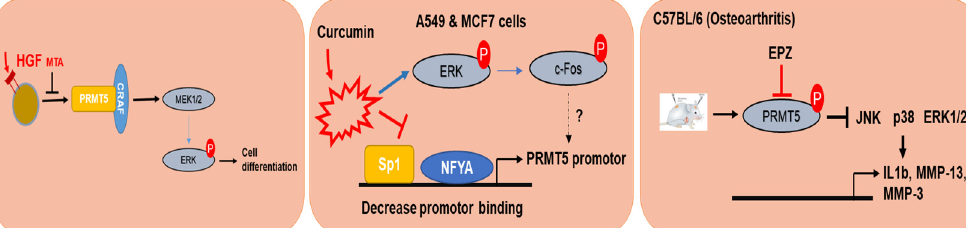
Figure 4. Mechanism and action of PRMT5 in different models. PRMT5-dependent methylation activates and enhances the degradation of CRAF resulting in reduced catalytic activity, and activation of downstream kinases, such as MEK1/2 and ERK1/2 in mouse melanoma cell lines. Transcription of PRMT5 was decreased by curcumin through modulation of the Akt-mTOR pathway and PKC-ERK1/2-p38-c-Fos kinase pathways. PRMT5 regulates the PETN-Akt axis in glioblastoma cell lines (GBM) [95].